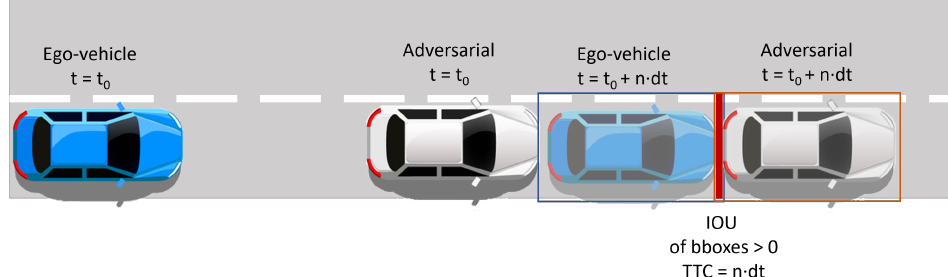
Figure 8. CTRV model prediction and IOU between both vehicles to determine